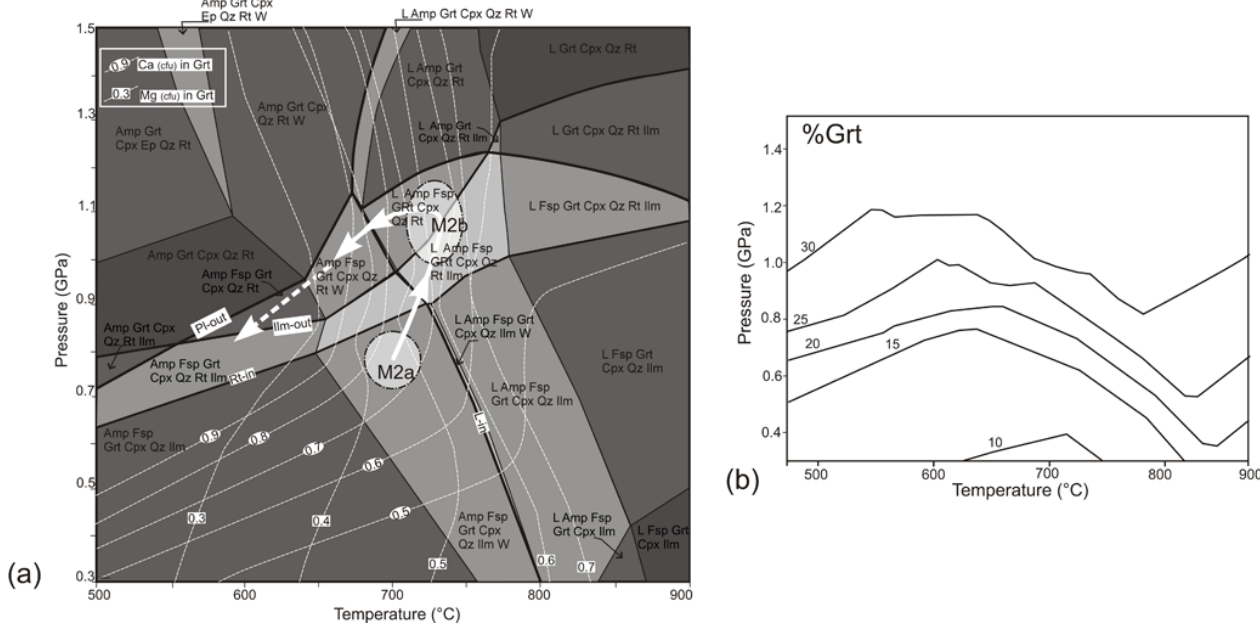
Fig. 11. (a) Representative P - T pseudosection calculated for the Sabzevar granulites in the system NCFMASHMnTO with a bulk compo- sition (wt%) Na 2 O 1.35, CaO 10.87, FeO 15.53, MgO 6.51, Al 2 O 3 12.92, SIO 2 45.99, MnO, 0.25, H 2 O 1.0, Ti O 2 3.04, O 2 0.01 by using the Perple X07 software. The dashed grey circles enclose the P - T spaces in which the M 1 and M 2 (metamorphic climax) assemblages are inferred to be located. The dashed white arrow indicates the P - T path followed by the Sabzevar granulites during their prograde and retro- grade history. (b) Predicted modal distribution of garnet in the modelled P - T field. Mineral abbreviations follow Whitney and Evans (2010) except for L, melt and W, H 2